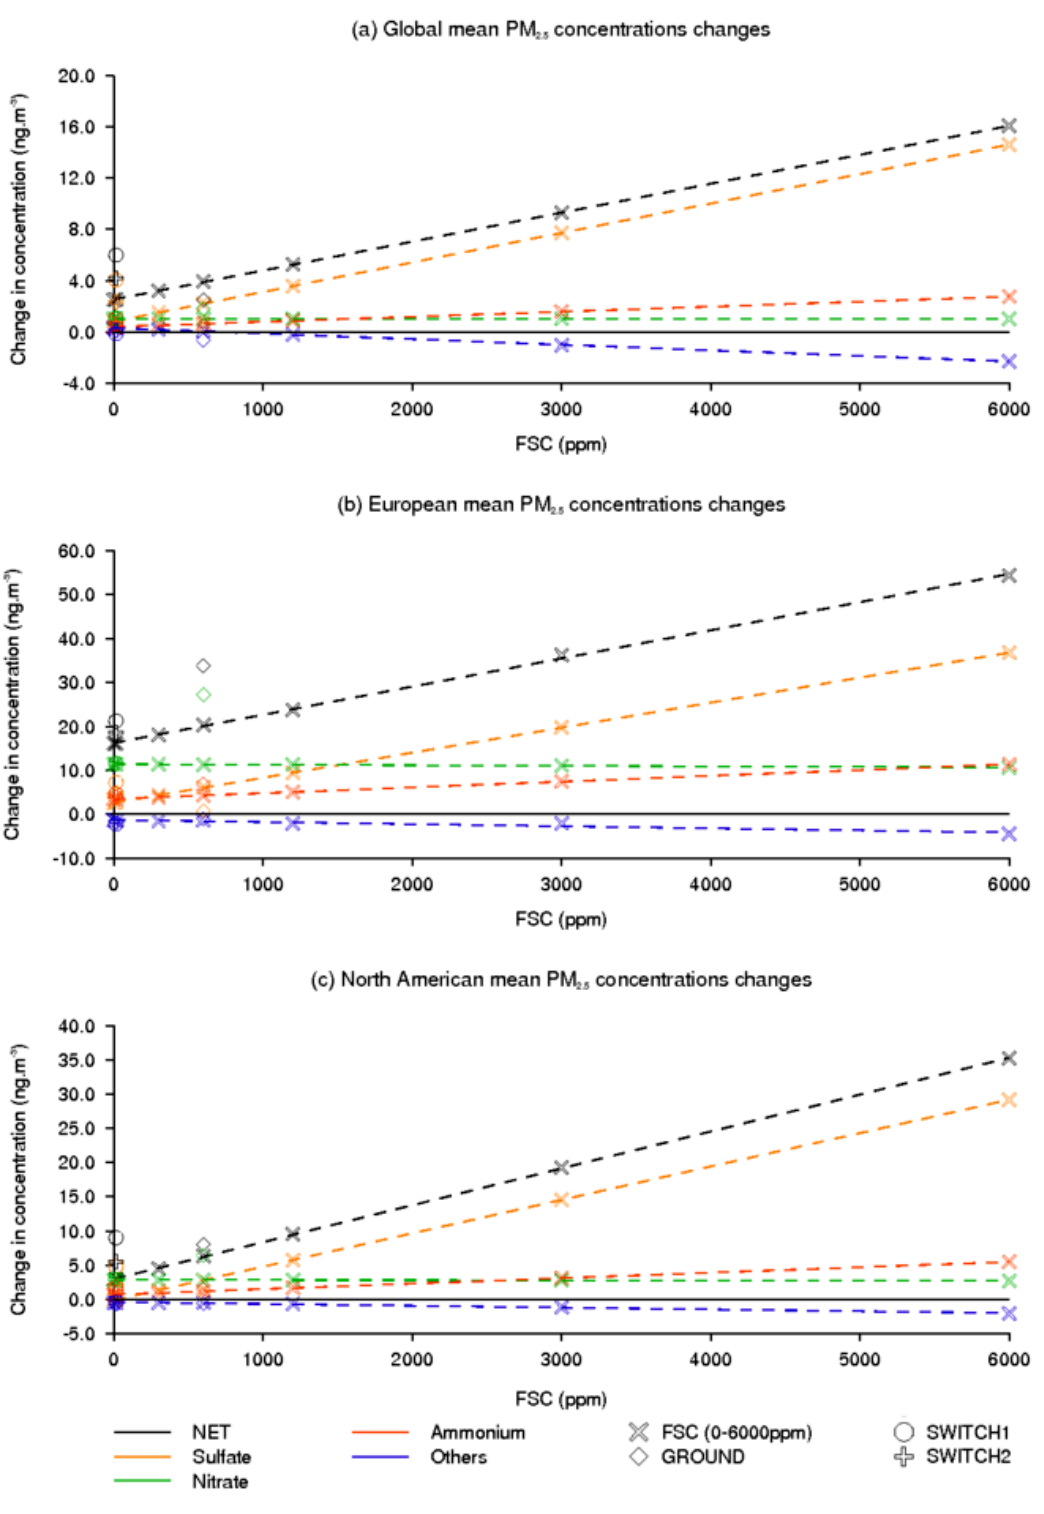
Figure 4. Impact of aviation FSC on (a) global, (b) European (20–40 ◦ E, 35–66 ◦ N), (c) North American (146–56 ◦ W, 29–72 ◦ N) surface annual mean PM 2 . 5 mass concentrations: FSC variations ( × ), GROUND ( (cid:5) ), SWITCH1 ( − ), and SWITCH2 ( + ) simulations. Solid lines demonstrate the linear relationship between FSC and PM 2 . 5